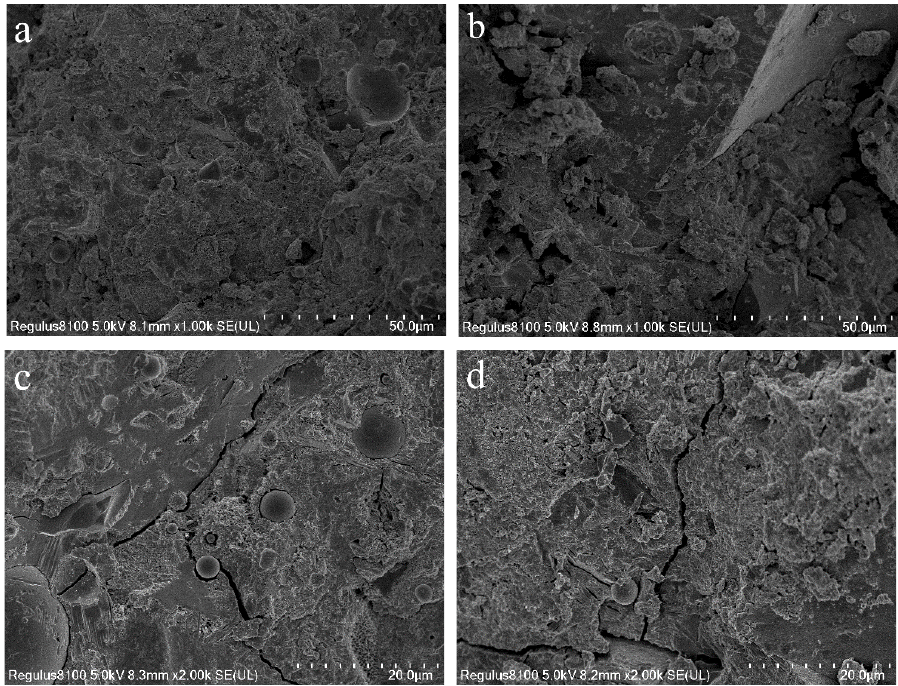
Figure 14. SEM of ferrochrome slag concrete (( a ). CG0 curing 7 d; ( b ). CG2 curing 7 d; ( c ). CG0 curing 28 d; ( d ). CG2 curing 28 d).